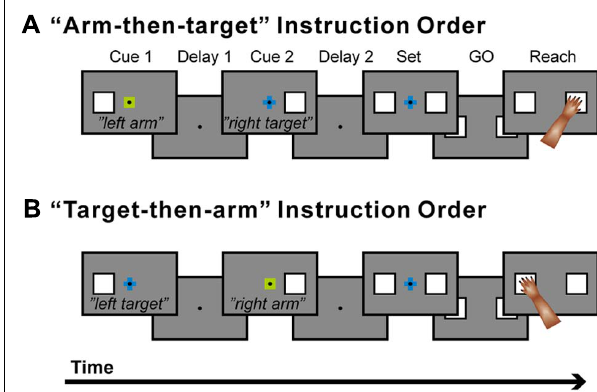
FIGURE 4 |Temporal sequence of behavioral events. (A) The trial in which a signal about arm use (“arm”) was followed by a signal about the target to reach for (“target”). (B) The trial in which the two signal were given in the reverse order.When a monkey placed one hand on each touch pad and gazed at a fixation point (FP), the first instruction (cue 1; 400 ms in duration), which contained information about either the target location or which arm to use, was presented. A small, colored cue indicated the type of signal (i.e., whether it related to target location or arm use). A green square was used for an arm-use signal, whereas a blue cross was used for a target-location signal. At the same time, a white square appeared to the left or right of the FP and indicated laterality of arm use (for arm-related instructions) or target location (for target-related instructions). After the subsequent delay period (delay 1) that lasted ≥ 1,200 ms, the second instruction (cue 2: 400 ms) was given to complete the information required for the subsequent action. After the second delay (delay 2: ≥ 1,200 ms), squares appeared on each side of the fixation point (set cue: ≥ 1,000 ms), signaling the monkey to prepare to reach for the target when the fixation point disappeared (the GO signal). If the monkey subsequently reached for the appropriate target with the appropriate arm, s/he received a reward. The order of appearance of the target and arm signals was alternated in a block of 20 trials, and laterality was randomized within each block. A series of five 250 Hz tones was presented after a reward signaled a reversal of the order of the